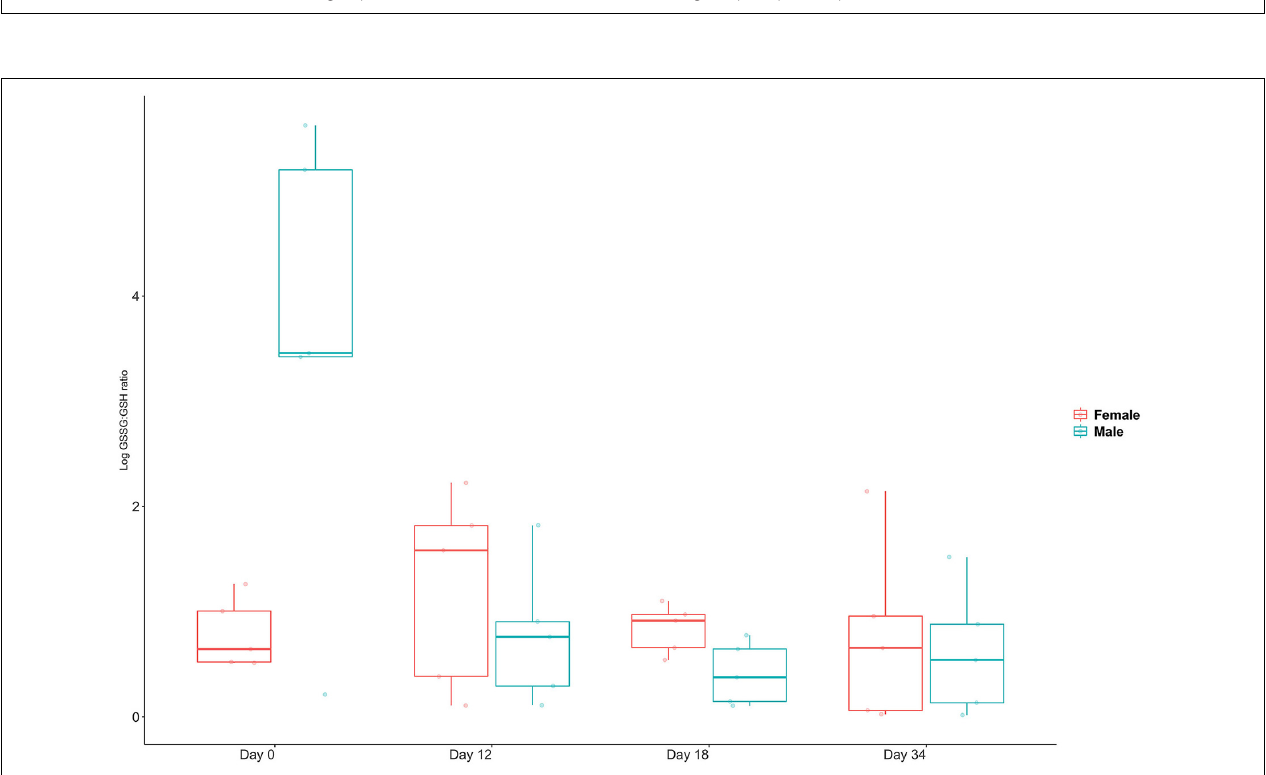
FIGURE 4 | Glutathione ratios for five female and five male C. tenuimanus held unpaired (day 0) and paired (from between day 1–12). Box-whisker plot showing median and range of individual